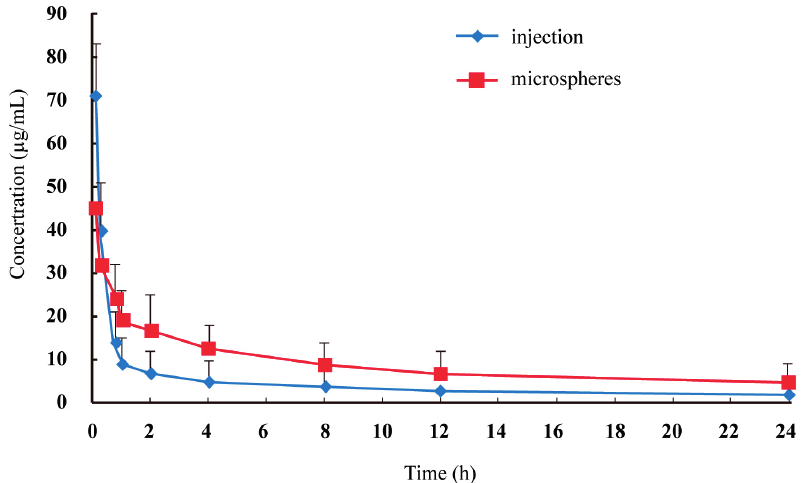
Figure 3. Mean plasma lidocaine concentration in rats after intravenous administration of two formulations ( n = 6).